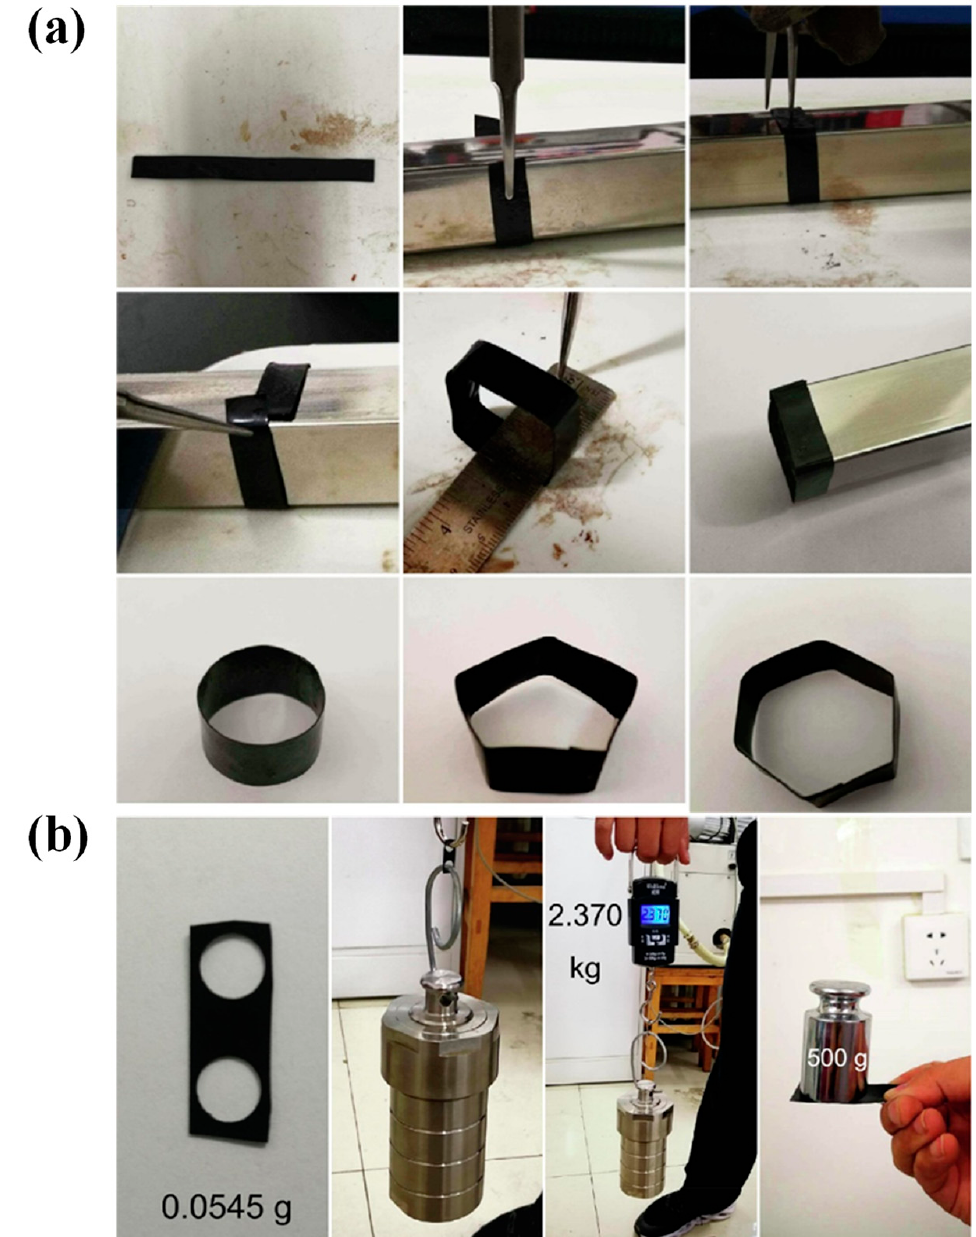
Figure 20. ( a ) Its initial, square, circular, pentagonal, and hexagonal shapes. ( b ) The film with two holes, hanging kettle, and lifting steel counterpoise. Reprinted with permission from Ref. [181]. 2021, Elsevier.